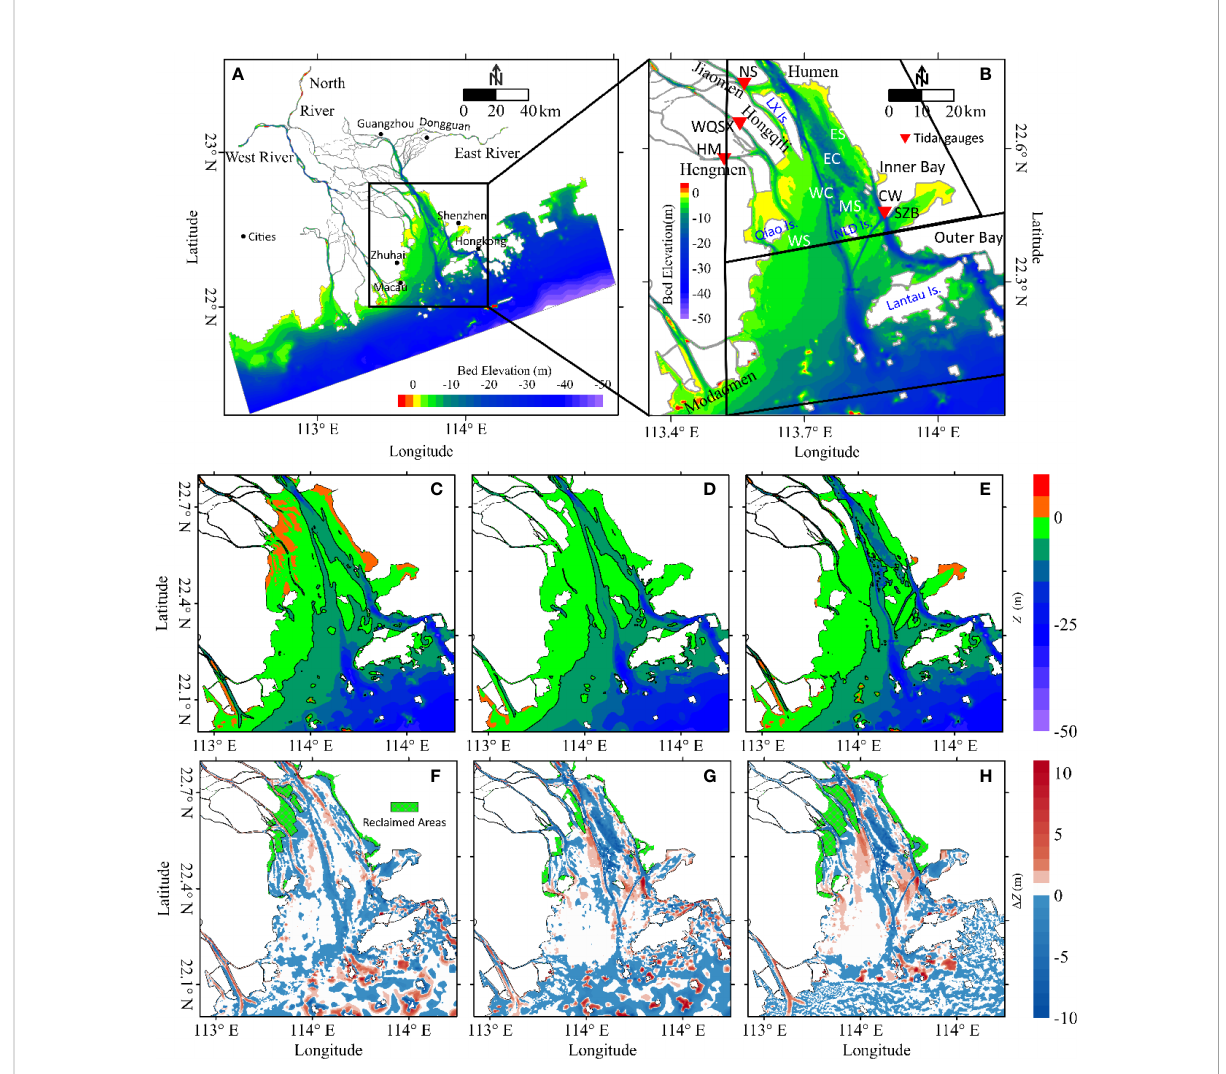
FIGURE 1 Location and bathymetry of the Pearl River Delta (A) and Lingding Bay (B) . The four red triangles in panel (B) represent tidal gauging stations: Chiwan (CW), Hengmen (HM), Wanqingshaxi (WQSX), and Nansha (Nansha). Lingding Bay can be divided into the inner bay and the outer bay in panel (B) . SZB indicates Shenzhen Bay. The four outlets are Humen, Jiaomen, Hongqili, and Hengmen. There are two channels and three shoals: The West Channel (WC), the East Channel (EC), the West Shoal (WS), the Middle Shoal (MS), and the East Shoal (ES). Bathymetry and shorelines of LDB in the year 1964 (C) , 1989 (D) , and 2014 (E) . Morphological evolution in LDB during the period of 1964-1989 (F) , 1989-2014 (G) , and 1964-2014 (H) . The reclaimed areas are shown with the green diagonal